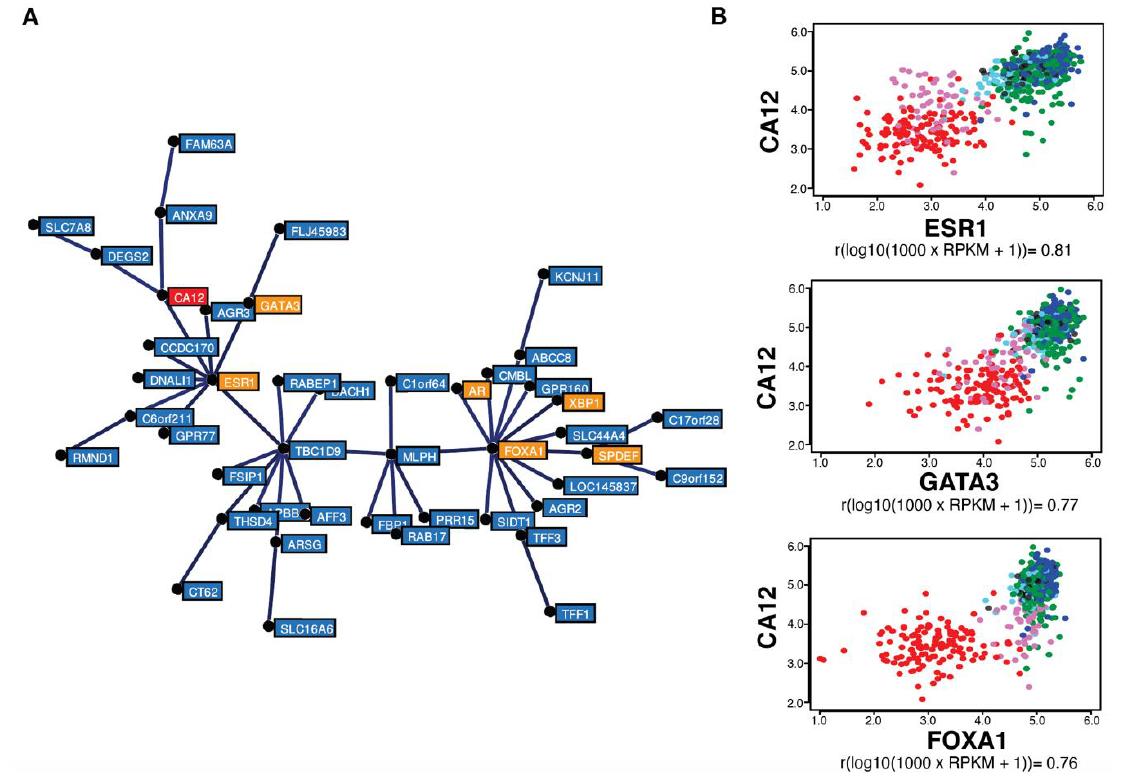
Figure 2 . CA12 mRNA levels are highly correlated with those of ESR1 , FOXA1 and GATA3 in breast tumors. ( A ) Minimum spanning tree representing a cluster of genes expressed preferentially in luminal and molecular apocrine breast tumors, identified by gene correlation analysis from a TCGA breast cancer transcriptomic dataset comprising 754 tumors using MiSTIC software [55]. Genes encoding transcription factors ( ESR1 , FOXA1 , GATA3, SPDEF , XBP1 and AR ) are highlighted in orange, whereas CA12 is indicated in red. ( B ) Pair-wise correlation scatterplots for CA12 and ESR1 (top), GATA3 (middle) or FOXA1 (bottom) expression levels in the same cohort, with CIT tumor subtypes highlighted by different colors. Luminal A tumors appear in dark blue, luminal B in green, luminal C in light blue, molecular apocrine in magenta and basal-like in red. Normal-like or non-classified tumors are shown in black. Pearson correlation coefficients are indicated at the bottom of each pair-wise correlation